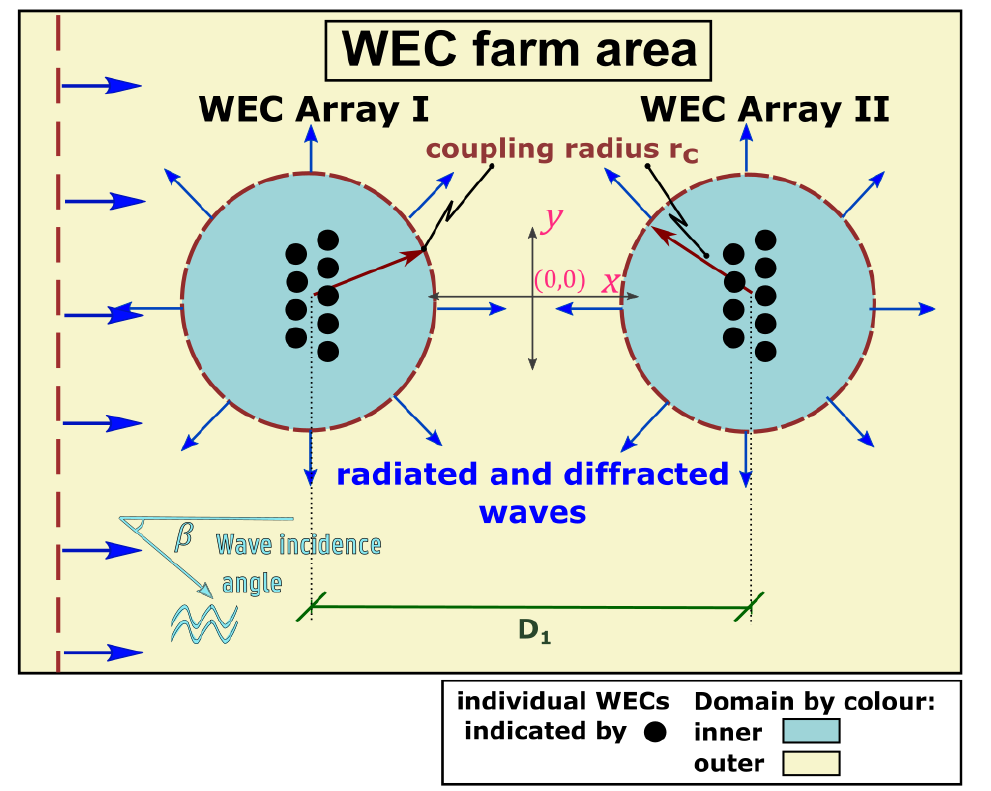
Figure 1. Schematic of the clustered wave-farm